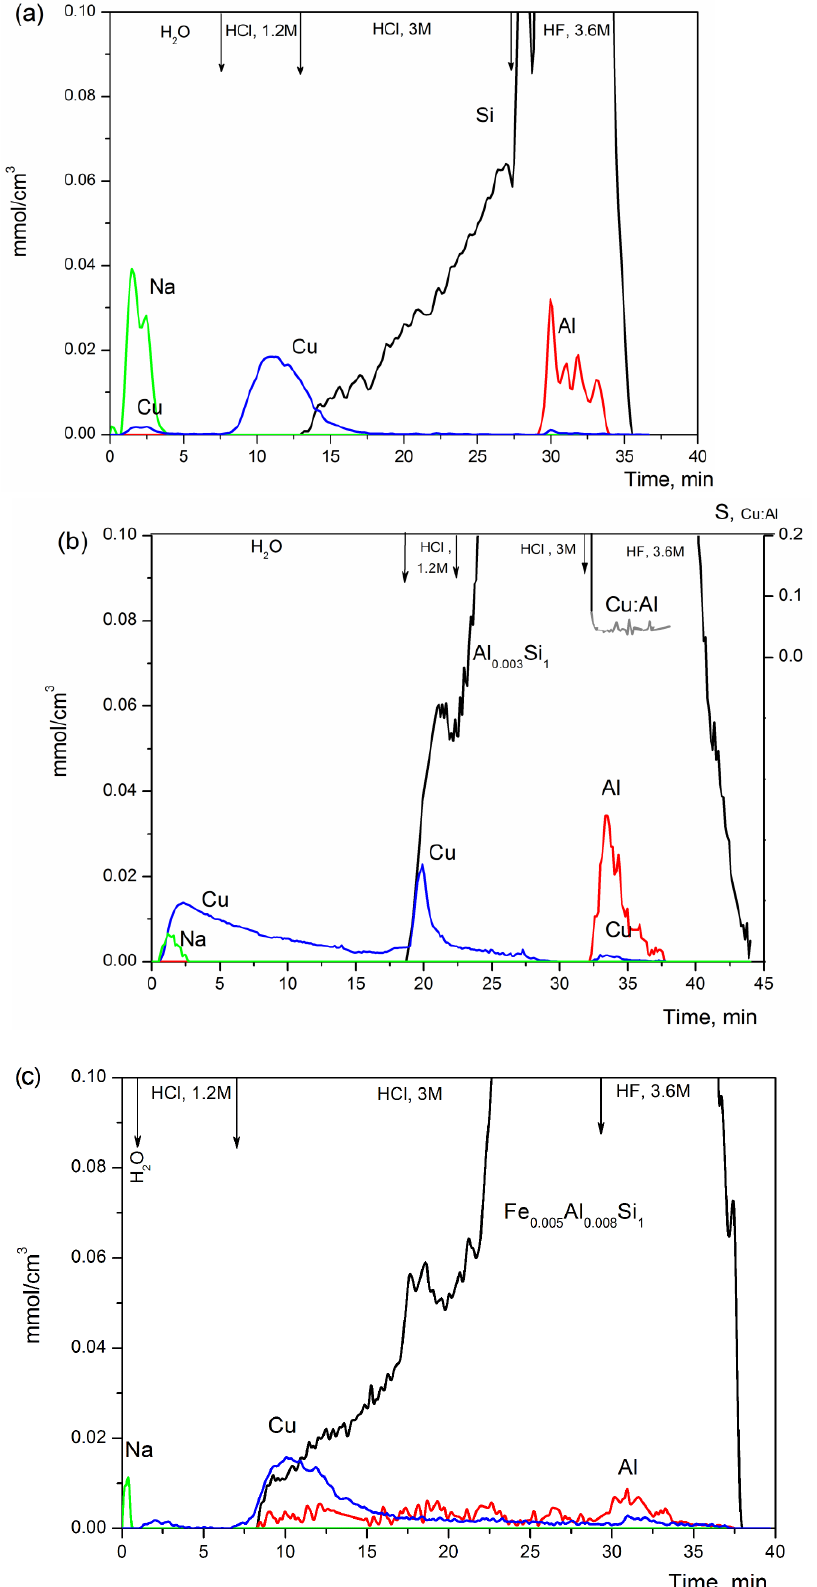
Figure 1. Differential dissolution curves of Cu-containing MFI prepared via solid-state transformation (( a ): 2%Cu-MFI-SST) and ion-exchange (( b ): 2%Cu-MFI-IEX, ( c ): 2%Cu-ZSM-5-IEX) modes. Table 2. Results of the chemical differentiating dissolution of Cu-containing zeolites.